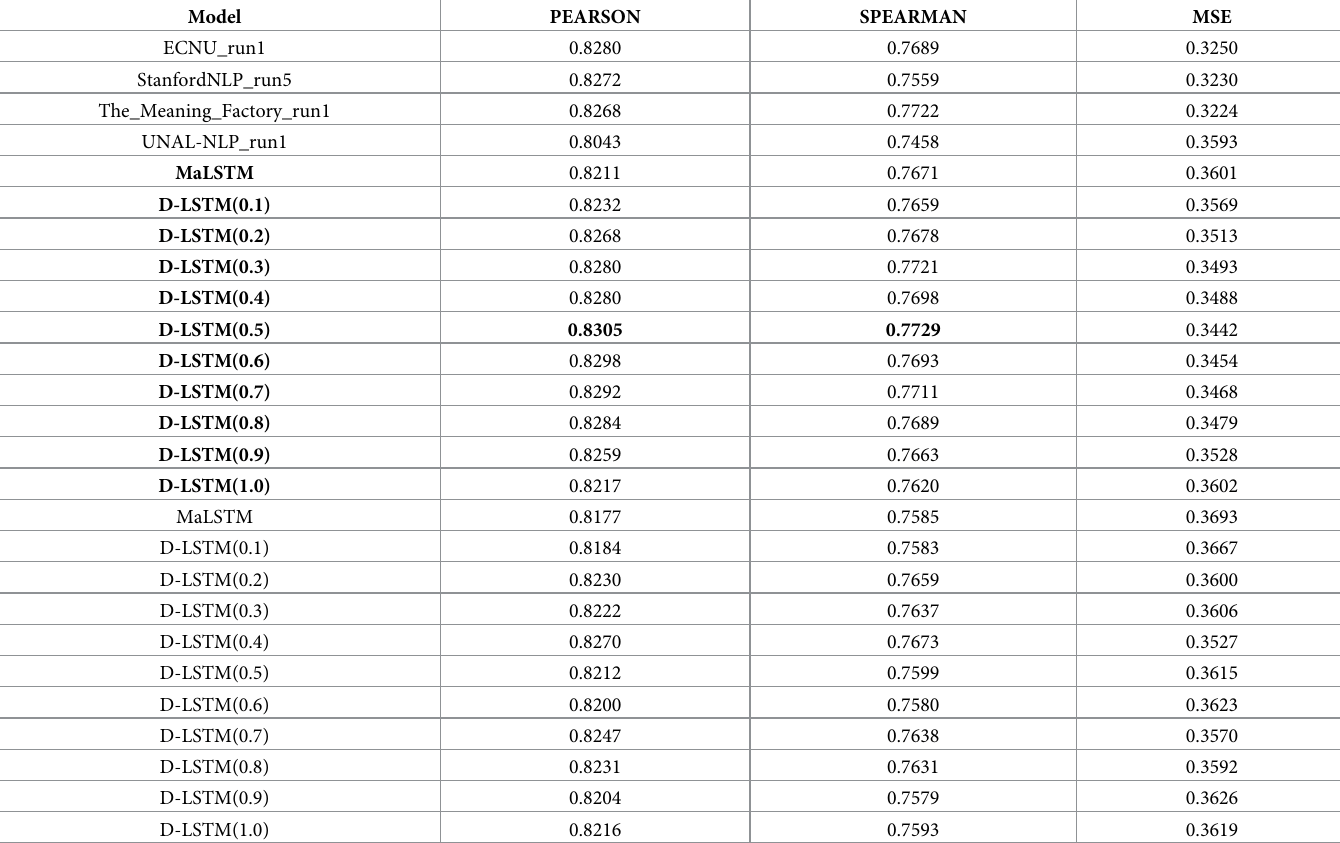
Table 2. Pearson’s r values, Spearman correlation and MSE for all models. Model